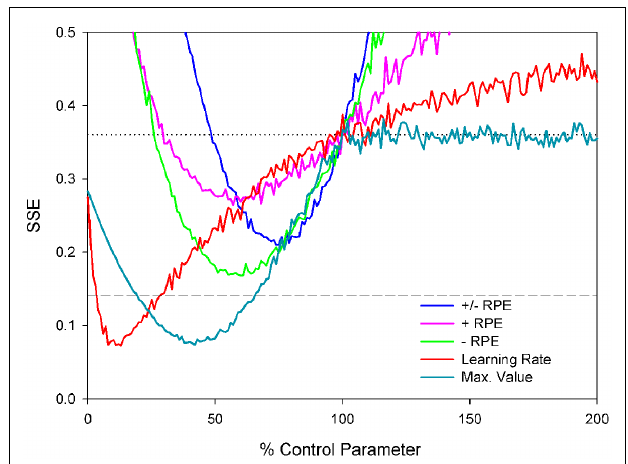
FIGURE 8 | Sum of squared errors (SSE) for each of the probabilistic learning task simulations. Note that the horizontal dashed line at SSE = 0.14 indicates the error value associated with the control simulation compared to the empirical control data and the horizontal gray dotted line at SSE = 0.36 indicates the SSE of the control simulation data compared to the empirical schizophrenia data; values below this line indicate better